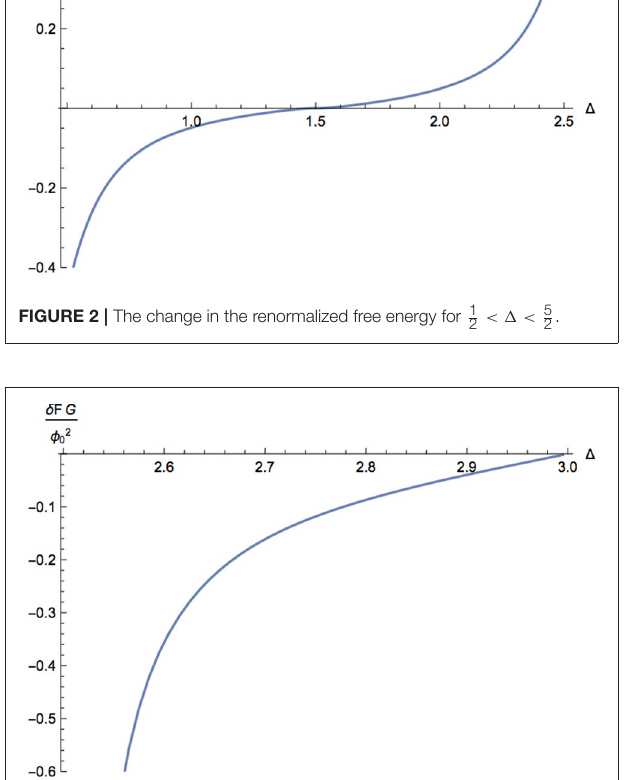
5 / 2 < 1 < 3, to demonstrate that the change of free energy is indeed zero for 1